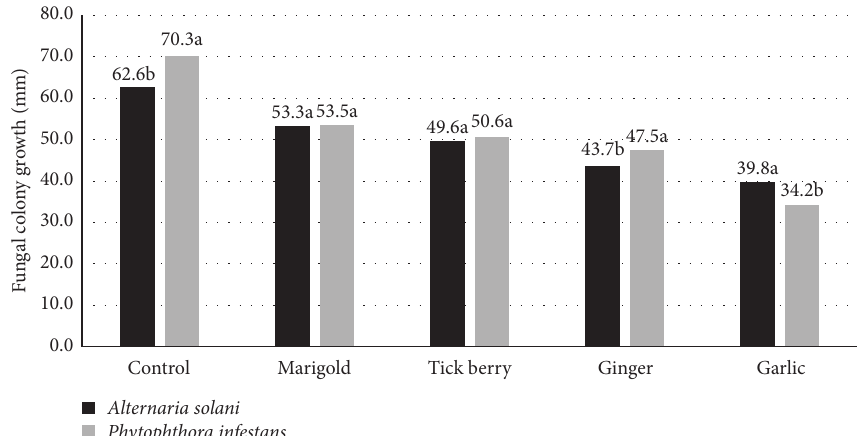
Figure 2: Comparative response of the two fungal pathogens to the crude extracts at day 7. Means with the same letter on the bars are not significantly different under the same test plant at p � 0 . 05. Table 4: Antimicrobial activity of essential oils on the growth of the fungal pathogens. Test material